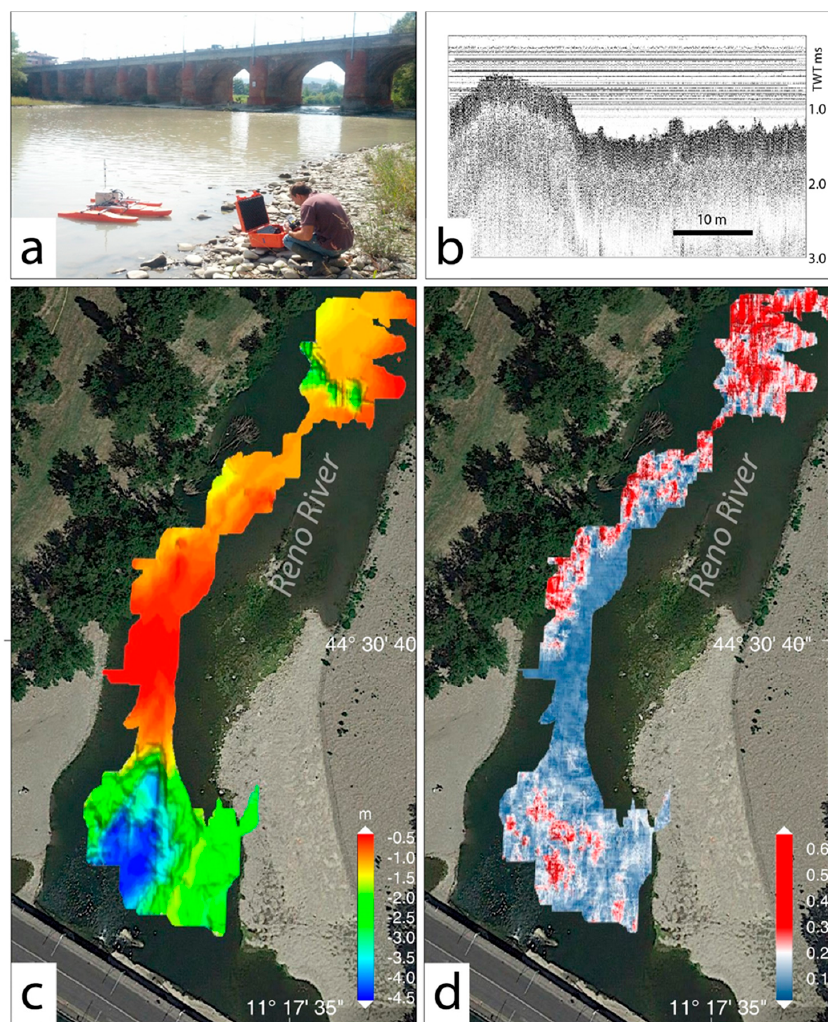
Figure 9. Echographic survey carried out along the Reno River close to an urban bridge (Bologna, Italy). ( a ) Configuration of the survey before start; ( b ) example of 200 kHz echogram in very shallow water; ( c ) morphobathymetric map highlighting the presence of a deep erosion close to the bridge pillar; ( d ) reflectivity map obtained using the same data showing sectors of prevalent erosion (red) and deposition (blue).